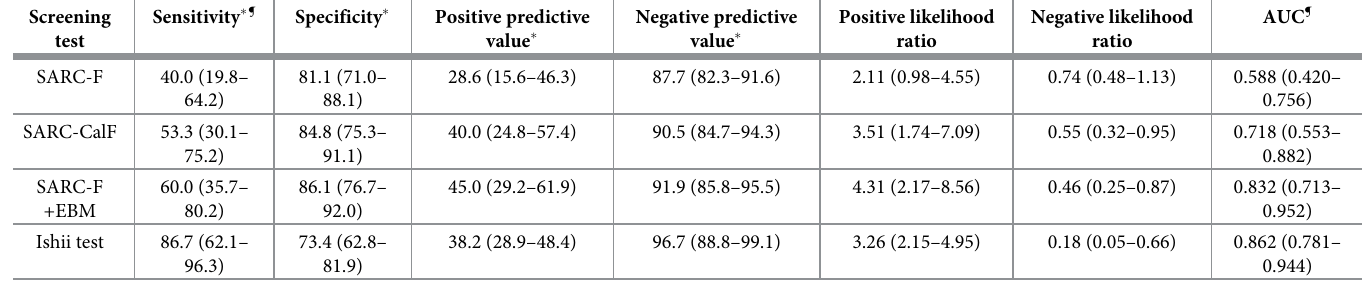
Table 2. Test characteristics and Receiver Operating Curve (ROC) models for the screening tests for identifying sarcopenia (EWGSOP2). Screening